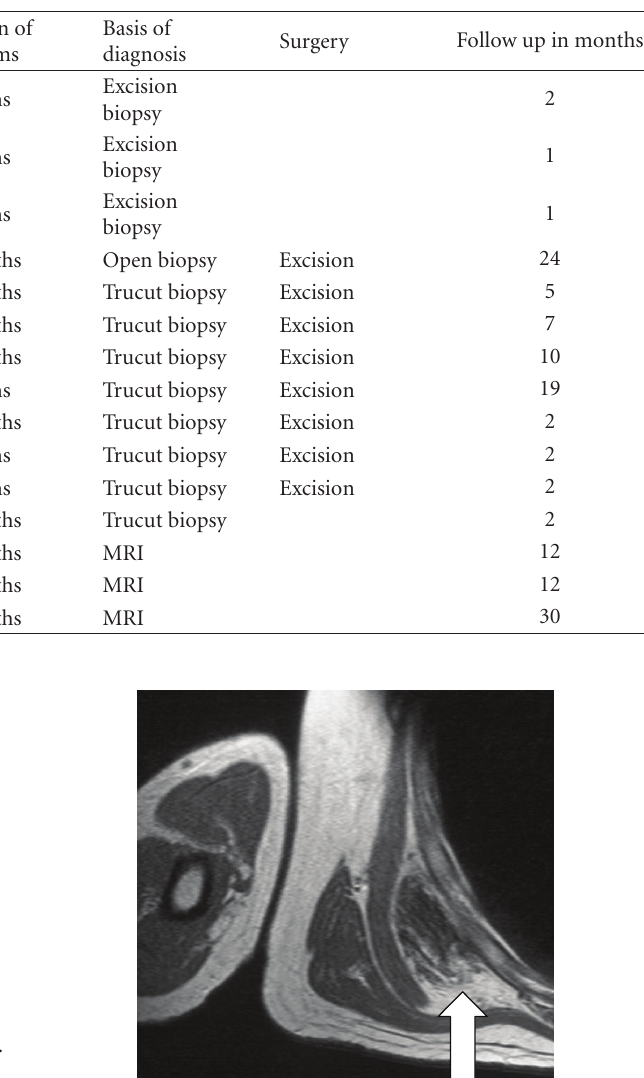
Table 1: Details of 15 patients with elastofibroma dorsi.